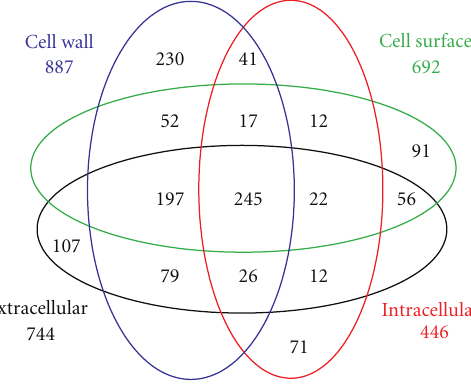
Figure 1: Venn diagram illustrating the total number of proteins identified from each fraction and the overlapping identifications using gel-based separation coupled to reverse phase LC-MS/MS and gel-free MudPIT analysis (LC/LC-MS/MS). Circles indicate the number of proteins identified with two or more peptide matches from the corresponding protein fraction with 99% or higher protein identification probability. The total number of proteins identified from each fraction is listed with the fraction name (e.g., 744 proteins were identified in the extracellular protein fraction from gel-based plus gel-free proteomic analysis of B. vietnamiensis